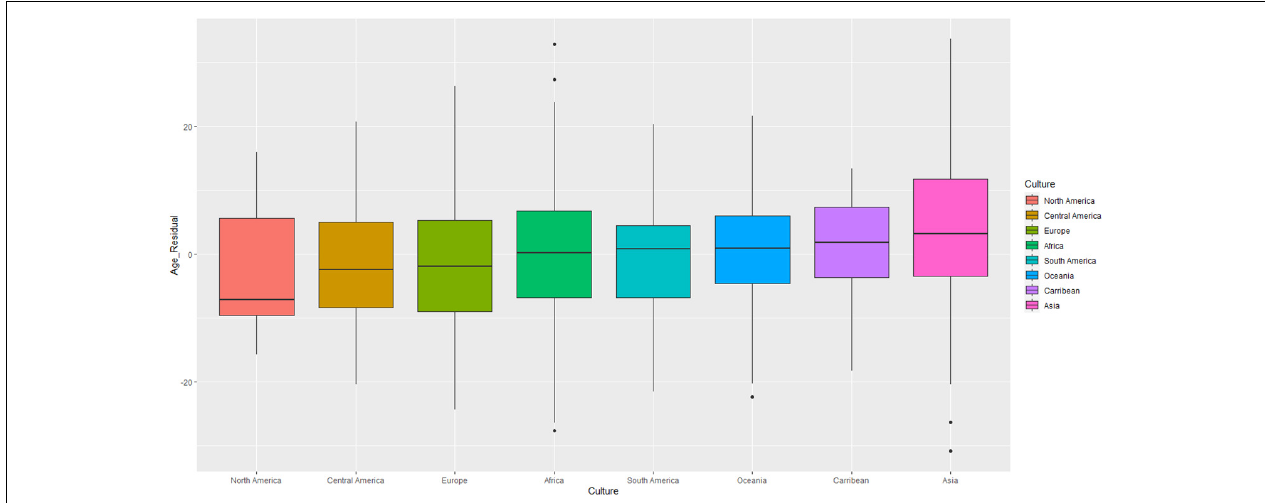
FIGURE 3 | Political leader ages by geographical region (Study 2). Age depicted in the figure is adjusted for the presence of the economic and elderly population covariates. See SOM for figures presenting raw (i.e., unadjusted by covariate) age scores.